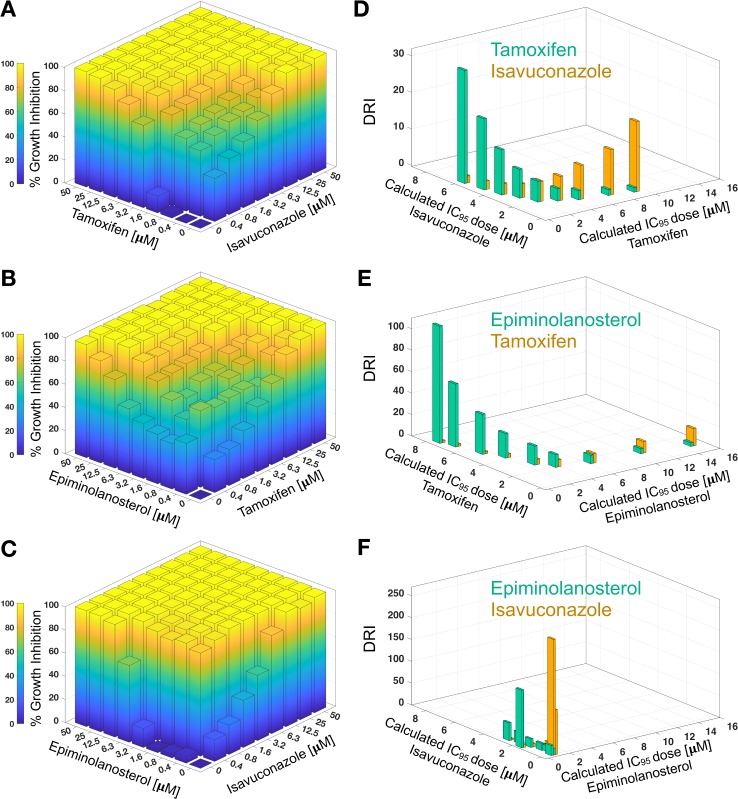
Growth inhibition of N. fowleri as a function of drug combinations.Heat maps show growth inhibition of N. fowleri by drug combinations: tamoxifen and isavuconazole (A), epiminlanosterol and tamoxifen (B), and epiminolanosterol and isavuconazole (C). Corresponding isobolograms (D, E, F) show the mean values of dose reduction index (DRI) ploted against calculated inhibitor doses required to achieve 95% growth inhibition. Standard deviations for each parameter mean value are shown in S2 Table.